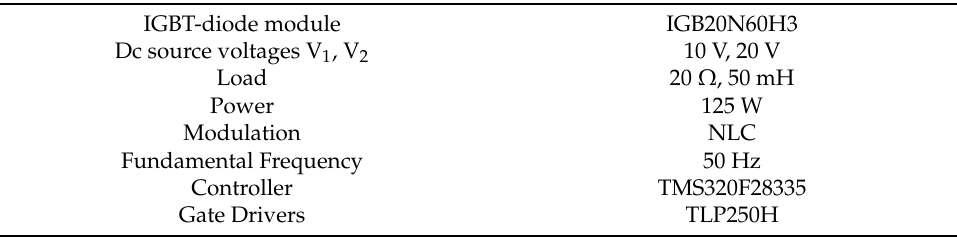
Figure 18. Experimental setup. Table 7. Experimental